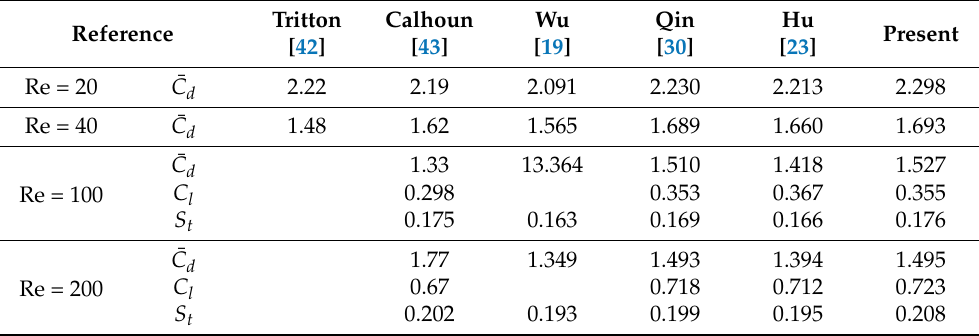
Table 3. Comparison of the drag coefficient, the lift coefficient, and the Strouhal number when Re = 20, 40, 100, and 200.